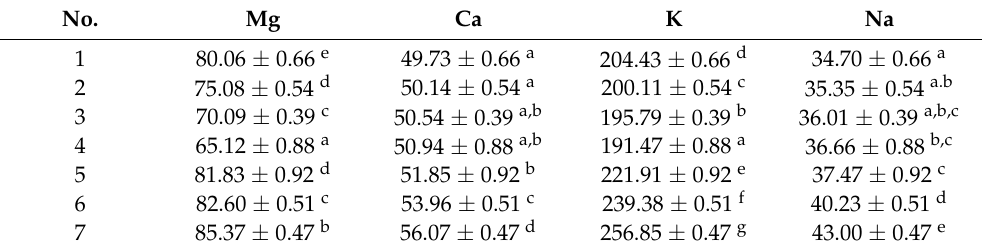
Table 3. The contents of selected minerals in muffins with Lyo apple and OT+Lyo apple powder (mg/100 g).